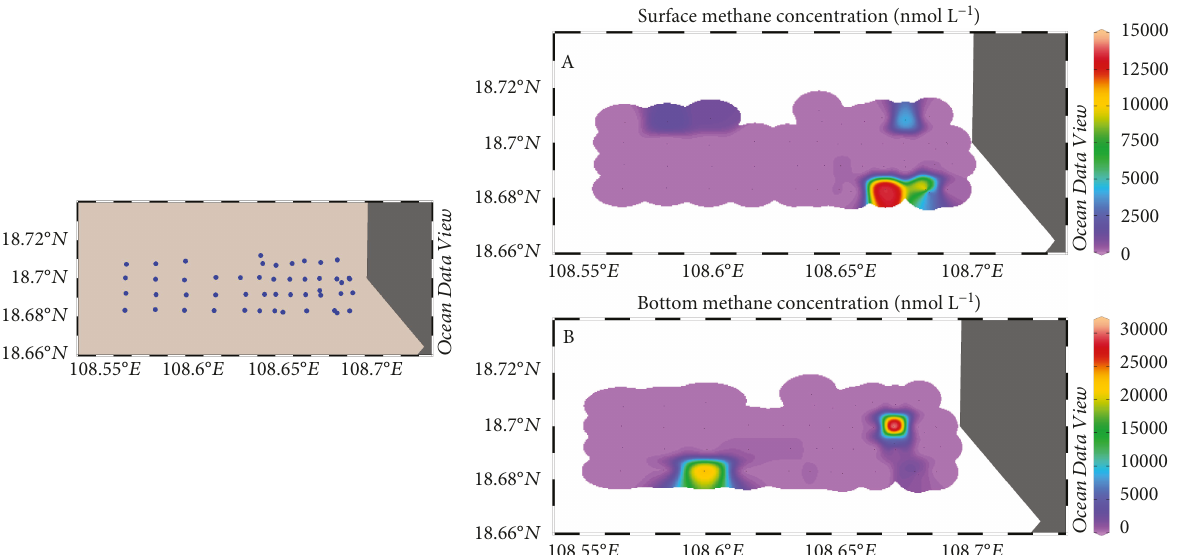
Figure 2: The distribution of dissolved methane concentrations in bottom waters and surface waters, respectively. The plot was generated using the Ocean Data View Version 4.5.7 (https://odv.awi.de) gridding weighted